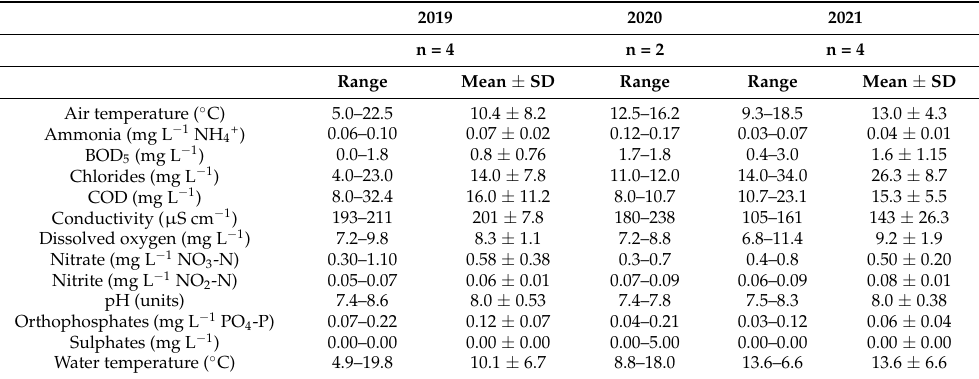
Table 1. Mean, standard deviation, and range of physicochemical parameters measured in the Palazzo Borghese pond in the years 2019, 2020, and